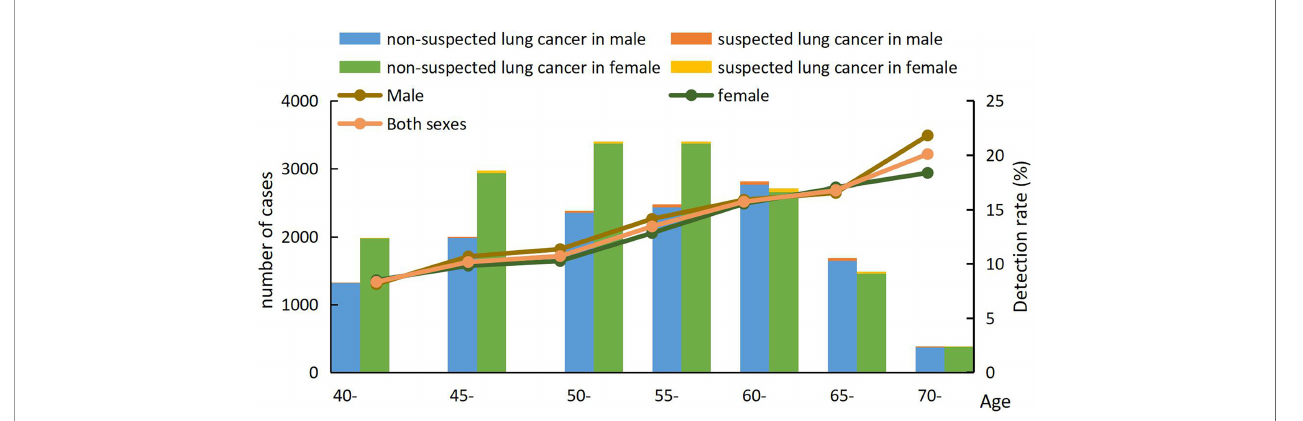
FIGURE 3 | Age-speci fi ed suspected lung cancer detection rate in Hebei province, 2013-2019.